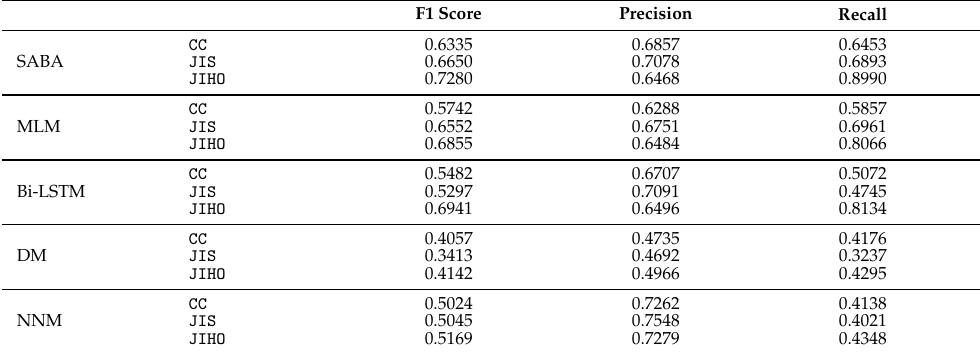
Table 3. Performance evaluation of the proposed self-attention-based autoencoder (SABA) model trained with the MLM paradigm, the respective version without SA (MLM), a distribution-based model (DM), and a K NN-based model (NNM). F1 Score Precision Recall CC 0.6335 SABA